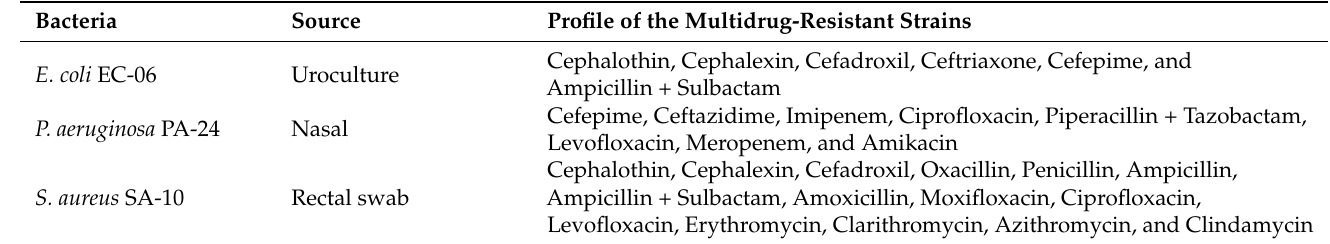
Table 1. Bacterial source and profile of the multidrug-resistant